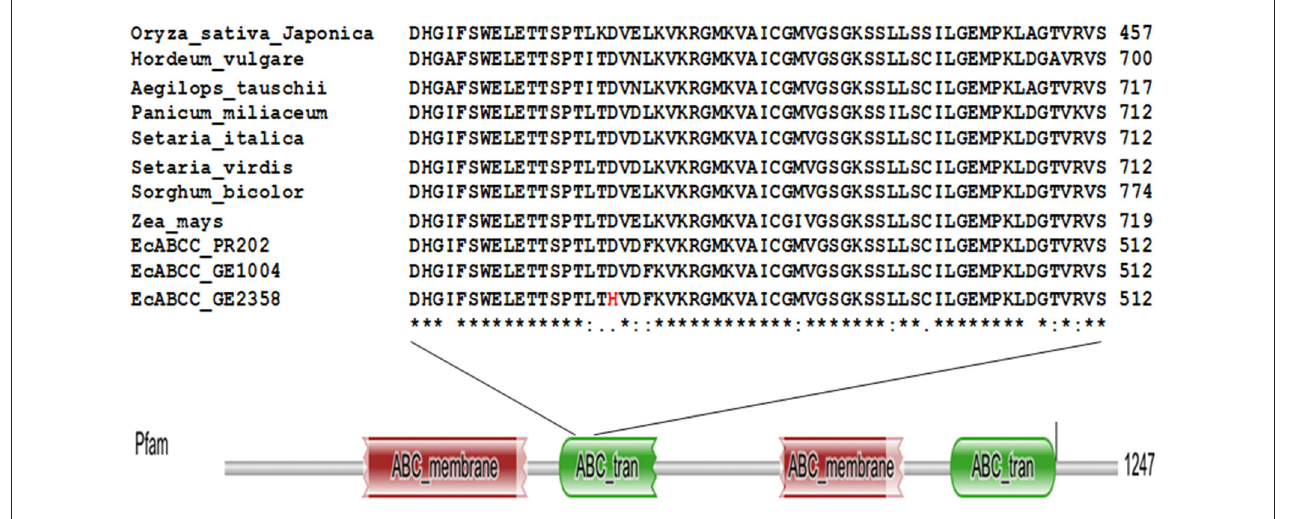
FIGURE 3 | Multiple sequence alignment of deduced amino acid sequence of EcABCC from GE2358, GE1004, PR202, and monocot crop species and domain search analysis of EcABCC. The amino acid indicated in red color is replaced amino acid in low GPA accession.